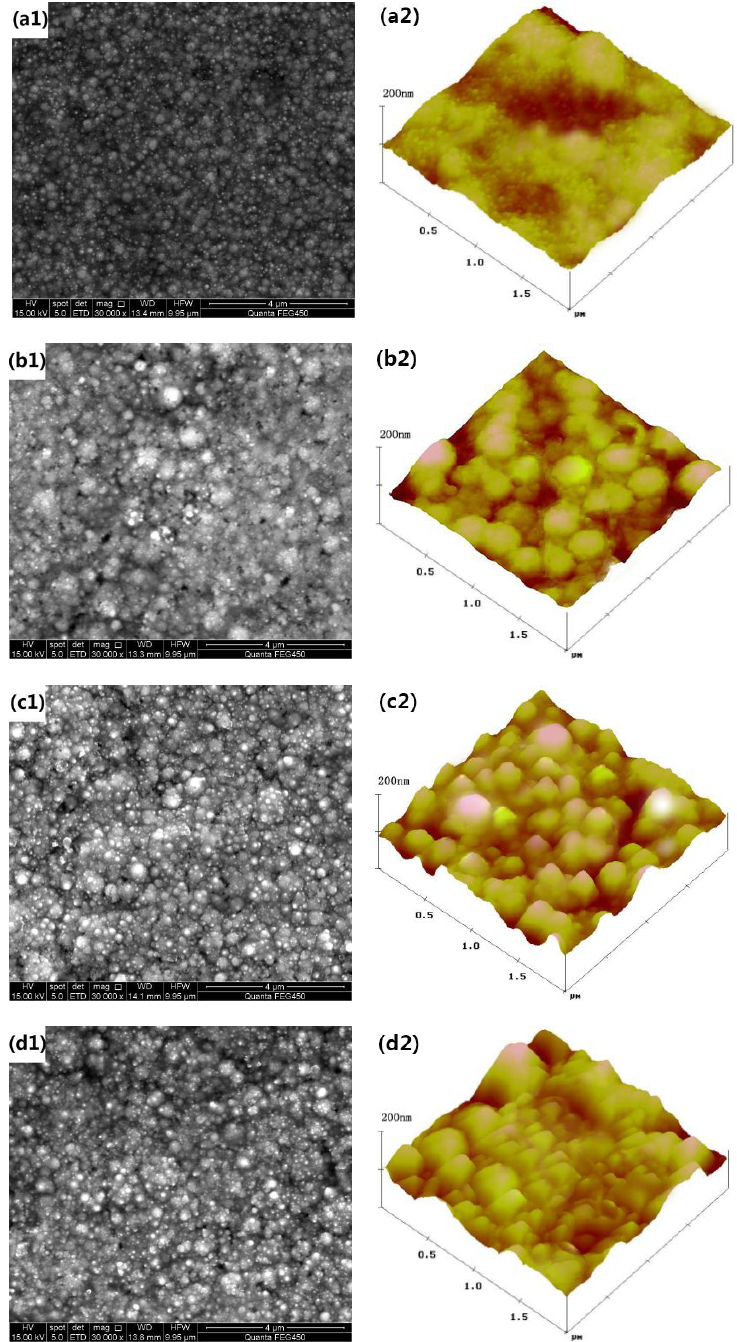
Figure 6. ( a1 – d1 ) SEM images of the filter film (400 meshes), which was heated and fixed by 0, 1, 2 and 3 spin-coating phenolic resin and hydrophobic nano-silica. ( a2 – d2 ) AFM image for the front side of the filter film (400 meshes), which was heated and fixed by 0, 1, 2 and 3 spin-coating phenolic resin and hydrophobic